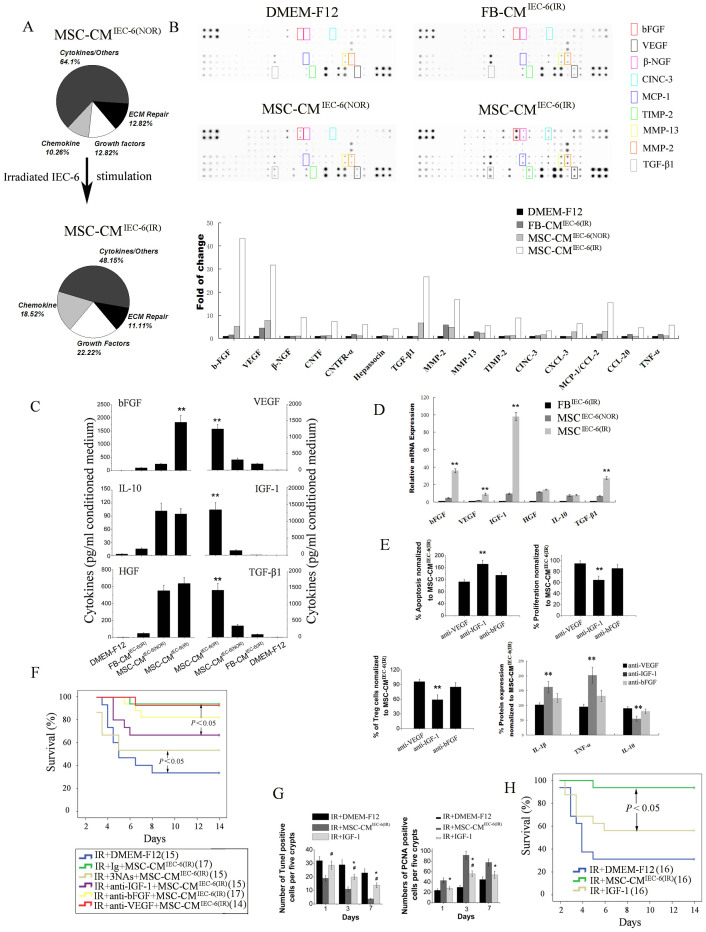
Activation of MSCs under radiation-induced inflammatory condition induces an alteration in the MSCs secretome.(A) The specific chemical composition of MSC-CM with or without inflammatory stimulation. (B) Identification of fifteen cytokines of MSC-CMIEC-6(IR) that are potentially beneficial to intestinal recovery. Fresh medium without cell culture (DMEM-F12) was used as a background control. (upper panel) Representative images of the cytokine antibody array are shown. The rectangles highlight cytokines higher in MSC-CMIEC-6(IR) than FB-CMIEC-6(IR) and MSC-CMIEC-6(NOR) (fold change > 2.0). Each sample consisted of a pool of unconcentrated conditioned medium from five different donor cells. Each measurement was duplicated reproducibly. (lower panel) The graphs show the relative intensity of the 15 cytokines. The expression in the control medium was arbitrarily set as 1.0. (C) The same unconcentrated conditioned medium was assayed by ELISA for six selected cytokines (bFGF, VEGF, IL-10, IGF-1, HGF and TGF-β1). (D) The same selected cytokines were further confirmed by Real-time RT-PCR. β-actin was used as a loading control. The results represent 3 independent experiments (mean ± SD), **, P < 0.05 versus MSCIEC-6(NOR). (E) Neutralization of IGF-1 in MSC-CMIEC-6(IR) partially suppressed the beneficial effects of MSC-CMIEC-6(IR) on apoptosis (upper left panel) and proliferation (upper right panel) of irradiated IEC-6. The apoptosis and proliferation were evaluated by quantification of TUNEL-positive and PCNA-positive IEC-6 cells 3 days after radiation, respectively. Moreover, in vivo, the induction of CD4+Foxp3+ Treg cells in MLNs (lower left panel) and the regulation of the pro-/anti-inflammatory cytokine balance in small intestine (lower right panel) were partially reversed by antibodies against IGF-1 3 days after radiation. n = 3 in each group. **, P < 0.05 versus IR + MSC-CMIEC-6(IR). (F) Cumulative survival analyzed using the Kaplan-Meier method. P-values were determined by log-rank testing. (G) The effects of of IGF-1 on the apoptosis (left panel) and proliferation (right panel) of irradiated intestinal epithelial cells evaluated by quantification of TUNEL-positive and PCNA-positive cells in histological sections, respectively. *, P < 0.05 versus IR + DMEM-F12, #, P < 0.05 versus IR + MSC-CMIEC-6(IR). (H) Cumulative survival analyzed using the Kaplan-Meier method. P-values were determined by log-rank testing.